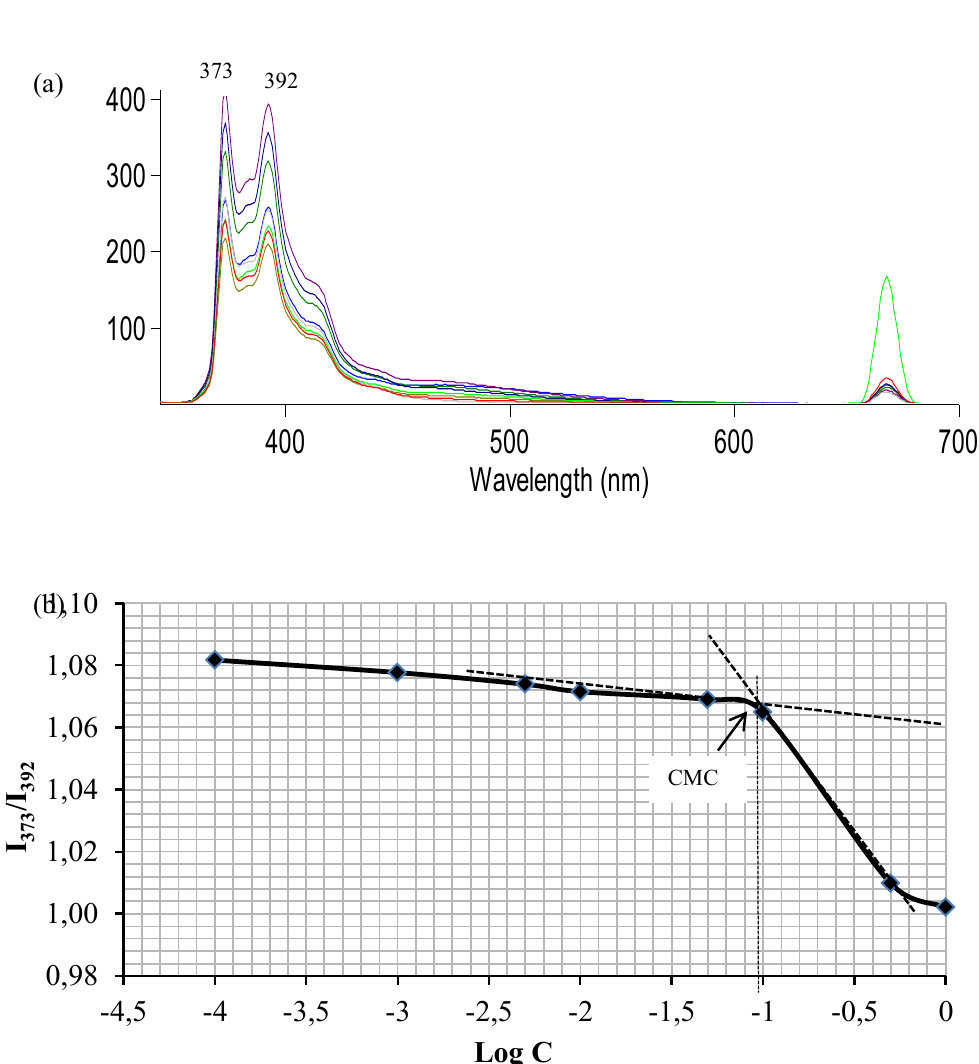
Figure 9: (a) The fluorescence spectra of pyrene (1.25 x 10 -3 mg/mL) in NOOGC solution (1.0, 0.5, 0.1, 0.05, 0.01, 0.005, 0.001 and 0.0001 mg/mL). (b) The intensity ratio (I /I ) of pyrene versus the logarithm concentration (Log. C) of NOOGC.